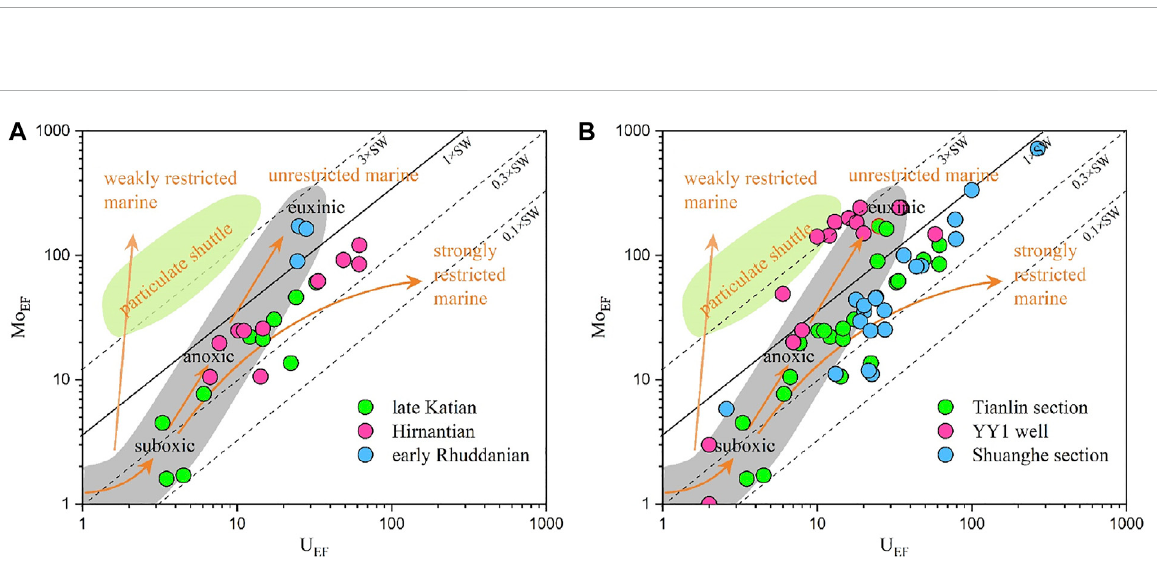
FIGURE 5 CovariantrelationshipbetweenU EF andMo EF forthe (A) Tianlinsectionand (B) Tianlin,YY1wellandShuanghesections.Thesolidlinerepresents the molar concentration ratio of Mo/U in seawater